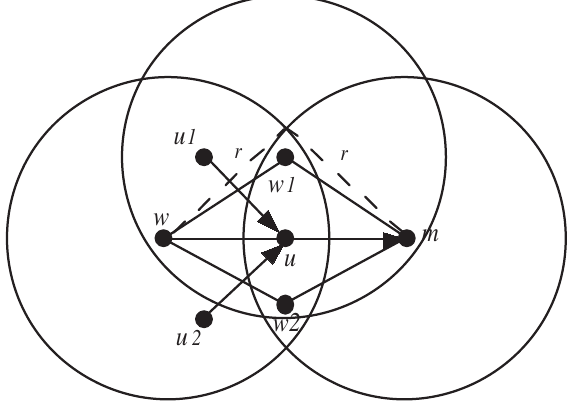
Figure 5. Communication between witness and monitoring